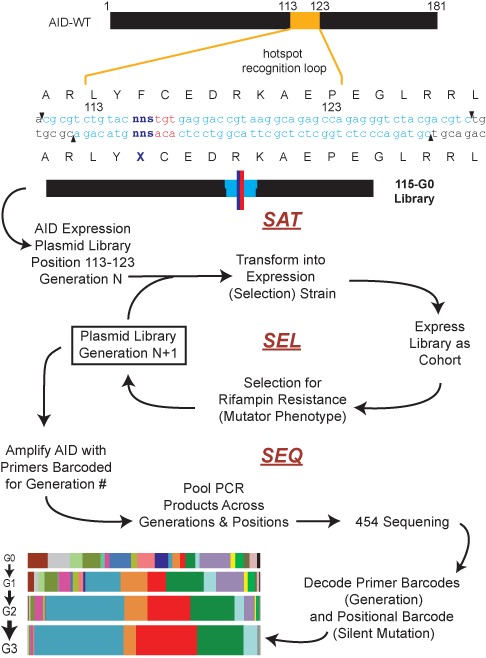
Sat-Sel-Seq methodology. Oligonucleotide cassettes (light blue) containing degenerate codons (NNS) at each position (dark blue) and neighboring silent mutations (red) were cloned into AID expression plasmid to construct saturation mutant libraries. Shown is the representative sequence of a Generation 0 (G0) library for Position 115. The G0 libraries were transformed into E. coli, expressed as a cohort and subjected to rounds of selection for acquired resistance to rifampin to generate subsequent generations of the library. The generational libraries were PCR amplified with primers barcoded for the generation number and the pooled PCR samples were sequenced by 454 high-throughput sequencing. The resulting data were decoded using generational and positional bar codes to catalog the evolution of codons over the generations at each position as shown in Supplementary Figure S1.